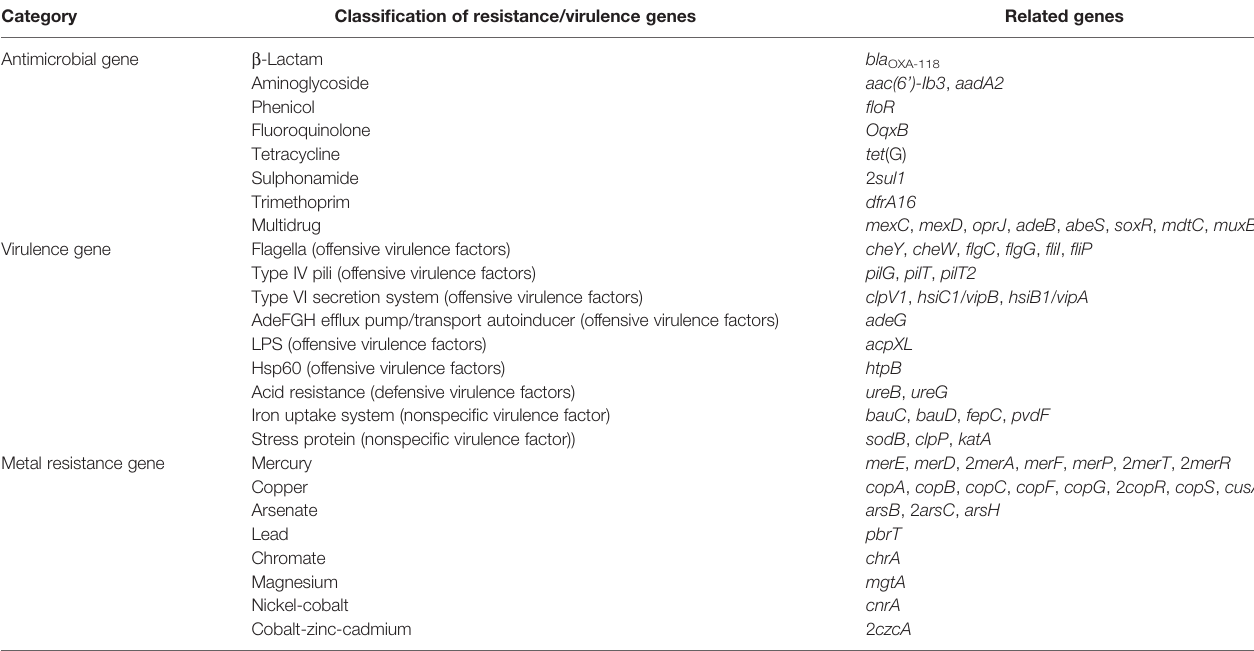
TABLE 3 | AMR, virulence and metal resistance genes identi fi ed in the D. tsuruhatensis TR1180 genome.